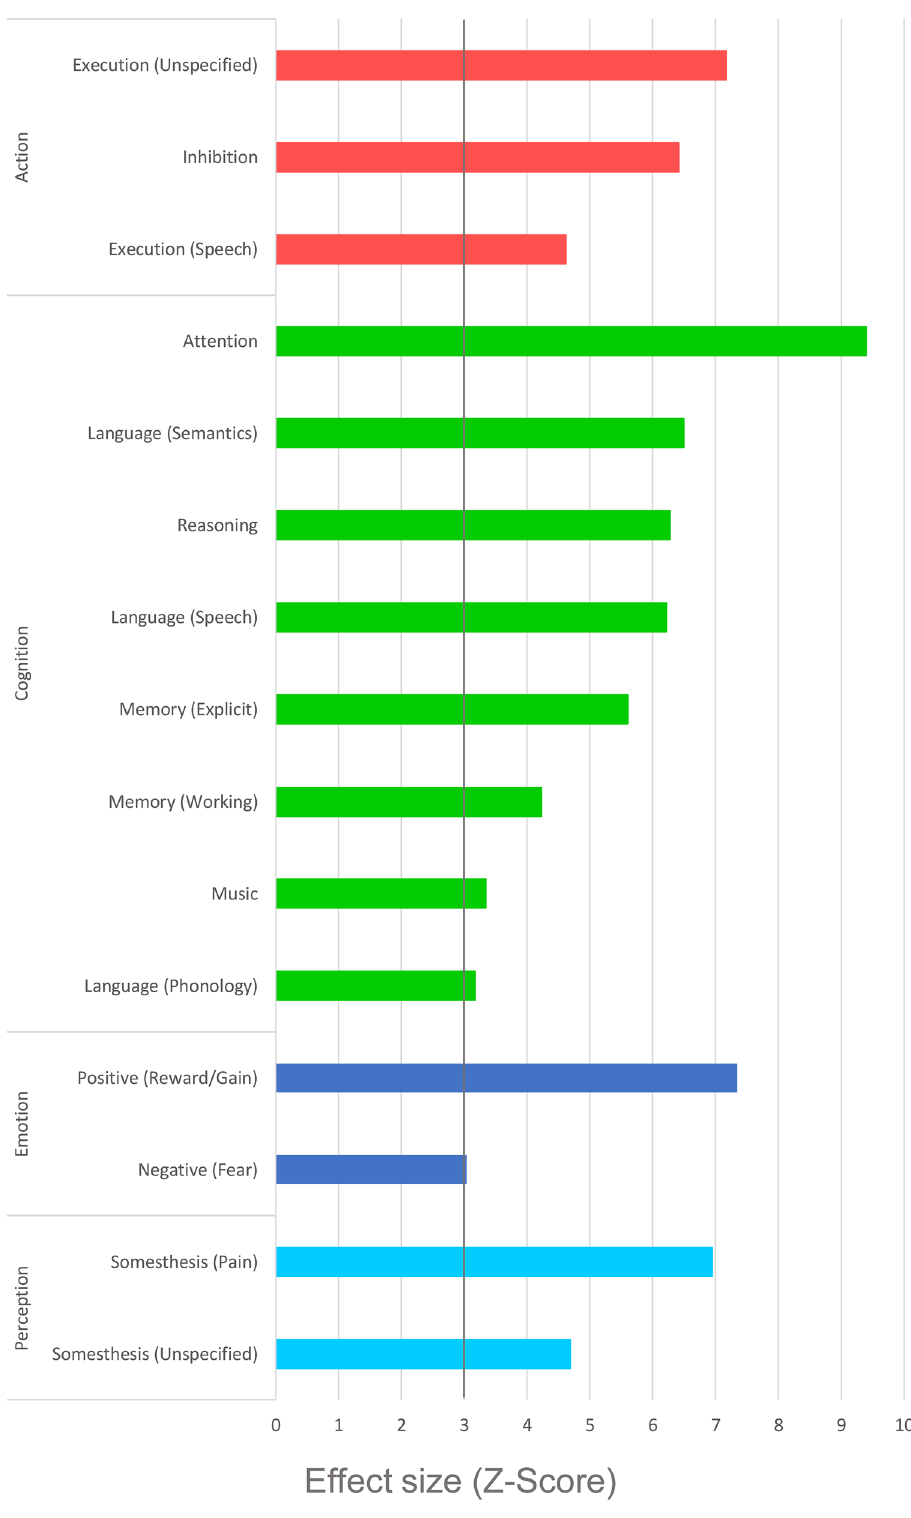
Figure 4 . Behavioral domain profile of the ALE derived cluster-network. Only domains with an effect size of Z > 3 are shown, as this is significant after correction for the size of the ROI/mask and the number of